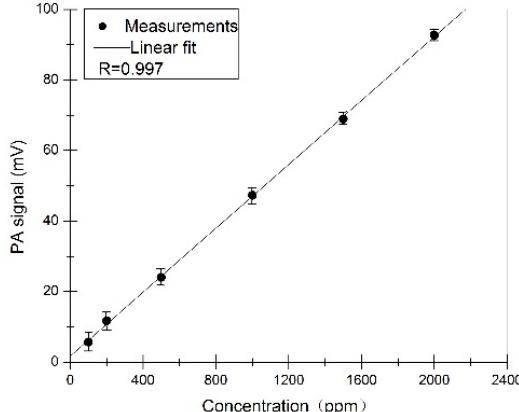
Figure 8. PA signals to different concentrations. Error bars give the range of the corresponding PA signals.